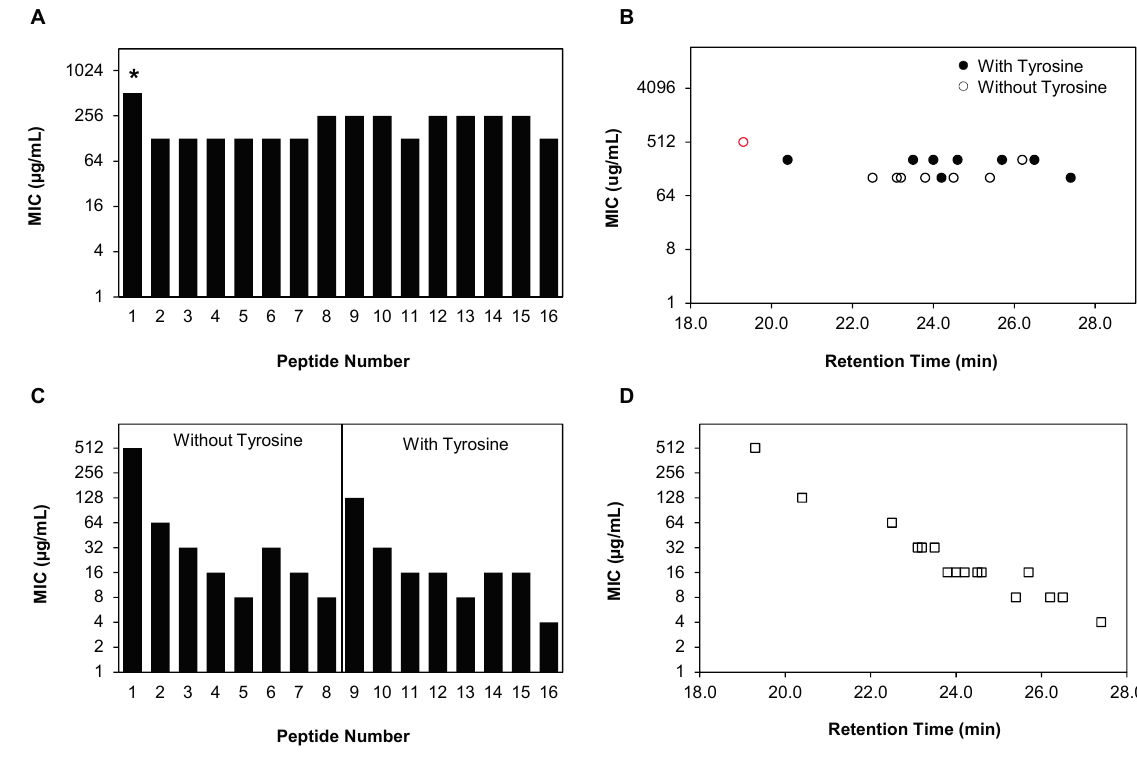
Figure 5. Antifungal activities of β -peptides against C. albicans biofilms. ( A ) Mature biofilms were formed by incubating C. albicans cells (10 6 cells/mL) for 48 h. Planktonic cells were removed, biofilms were washed, and 2-fold dilutions of β -peptides were added and incubated for an additional 48 h. β -peptide MICs were quantified using an XTT assay to compare the absorbance at 490 nm for β -peptide-treated samples and untreated samples. ( B ) Plot of biofilm MICs versus RP-HPLC retention times of peptides 1 – 16 against C. albicans for peptides without (white circles, peptides 1 – 8 ) and with (black circles, peptides 9 – 16 ) an N-terminal β 3 -hTyr residue. ( C ) MICs against C. albicans biofilm formation were determined by incubating C. albicans cells (10 6 cells/mL) with 2-fold dilutions of β -peptides for 48 h. Planktonic cells were removed, biofilms were washed and β -peptide susceptibility was assessed using an XTT assay to compare the absorbance at 490 nm for β -peptide-treated samples and untreated samples. ( D ) Plot of MICs to prevent biofilm formation versus RP-HPLC retention times of the peptides 1 – 16 against C. albicans. Experiments were performed on at least two independent days with three replicates each. Asterisks ( * ) and red symbols indicate that MIC was > 512 µg/mL, the highest concentration of peptide